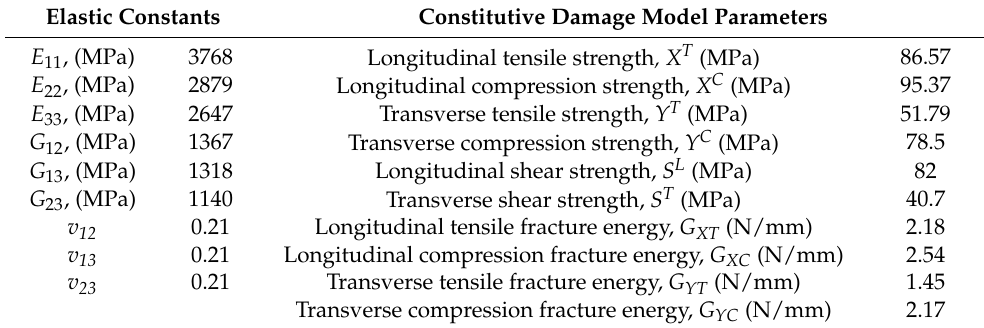
Table 1. Properties of phenolic resin impregnated Nomex polymer-based paper.